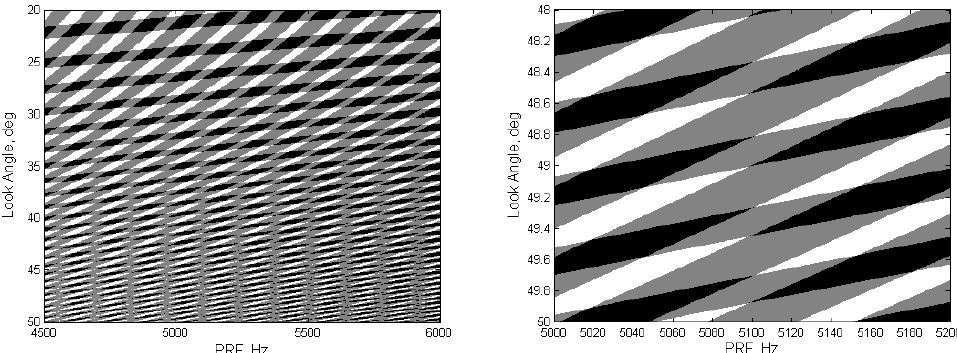
Figure 1. Illustration of PRF excluded zones as a result of transmit and nadir interference. ( a ) PRF: 4500 Hz–6000 Hz, look angle: 20°–50°; ( b ) PRF: 5000 Hz–5200 Hz, look angle: 48°–50°.